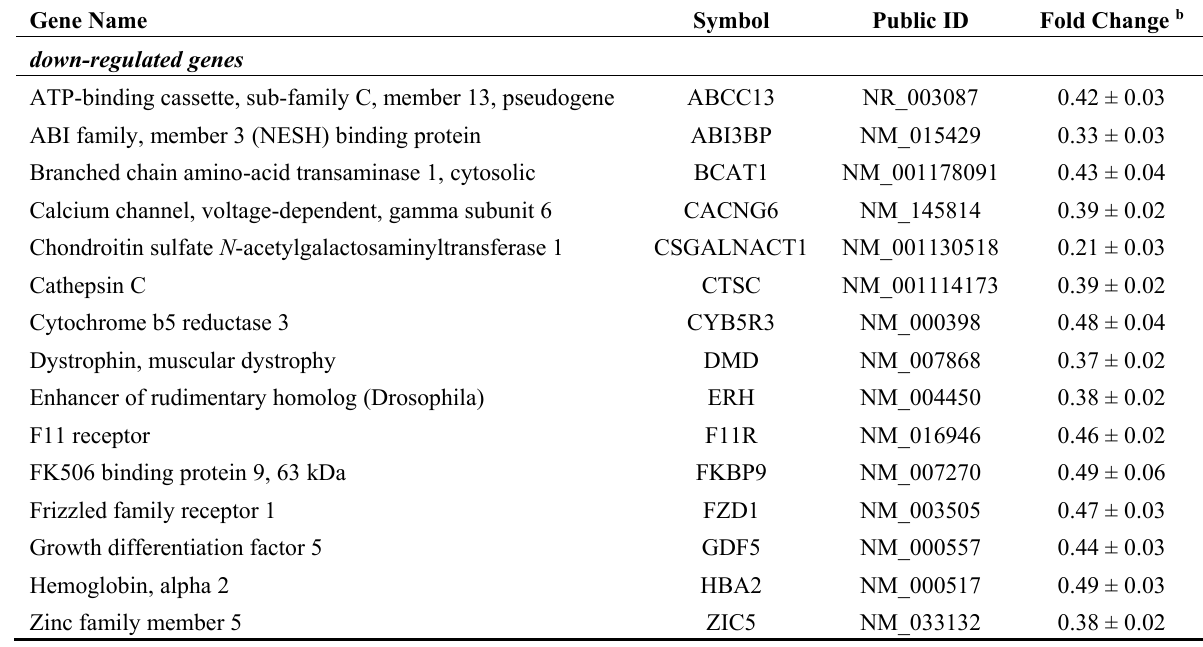
Table 1. List of the 20 signature genes in KBD patients a